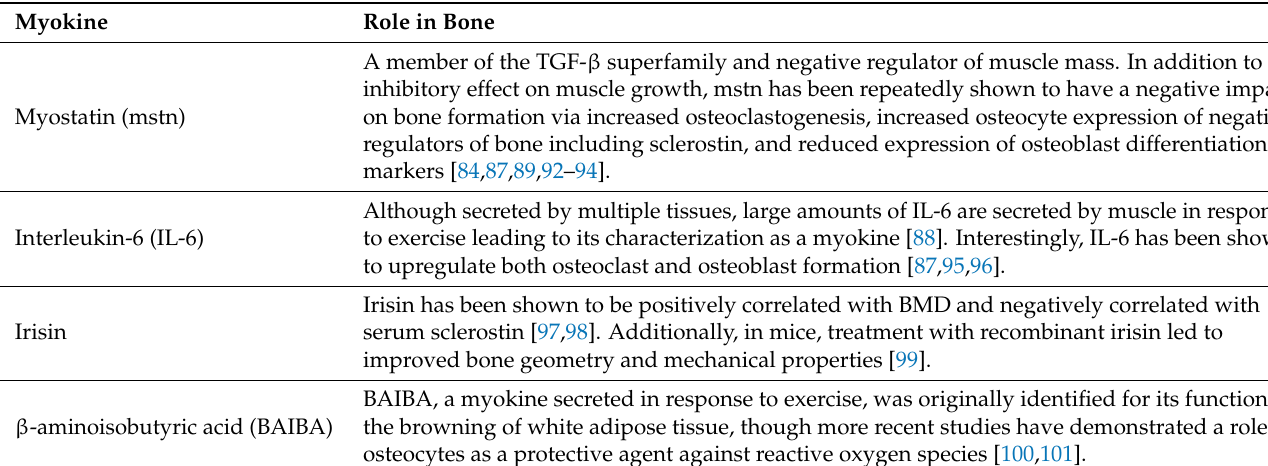
Table 1. Myokines and their roles on bone.